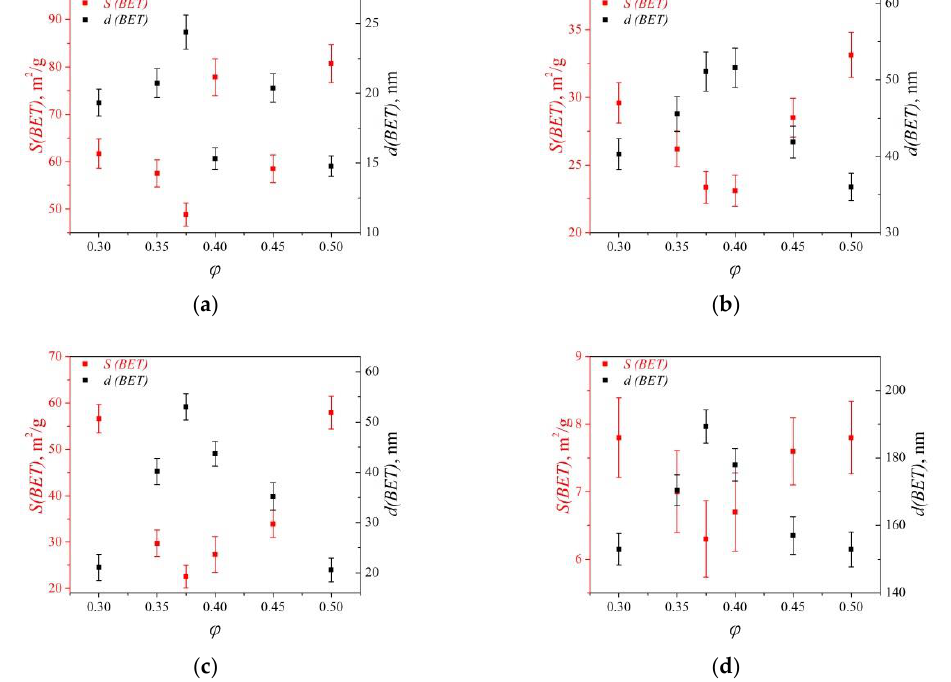
Figure 4. Specific surface area and calculated equivalent diameter of Y 2 O 3 particles depending on the SHS precursor composition: ( a , c ) as-prepared, ( b , d ) after air calcination at 800 ◦ C for 5 h, ( a , b ) without LiF, and ( c , d ) with